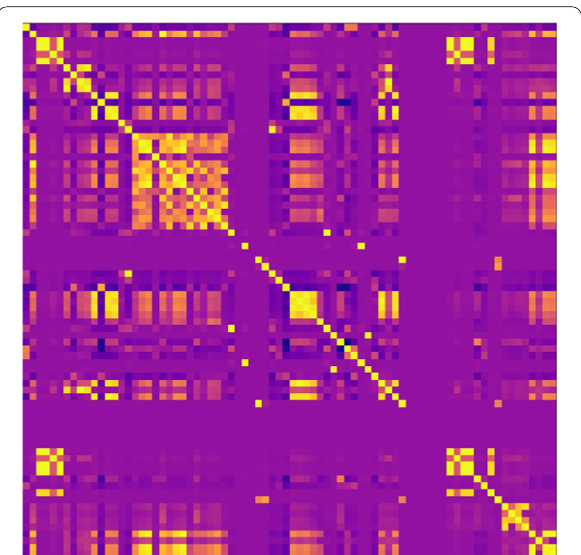
Fig. 6 Heat map of NSL-KDD feature inter-correlation